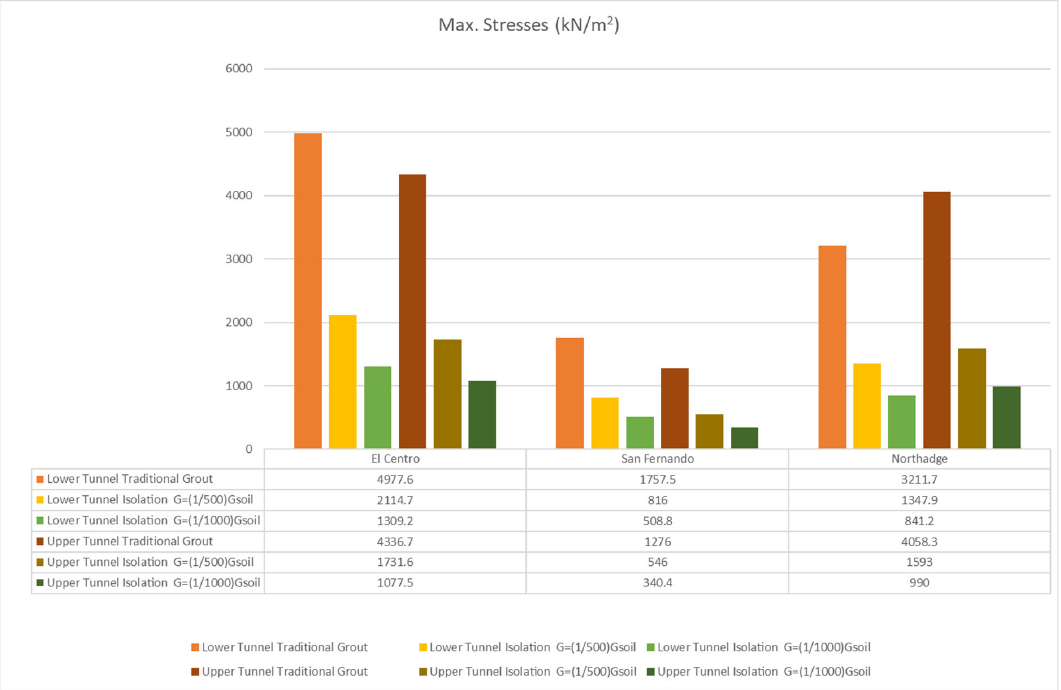
Figure 14. Maximum transverse stresses of the upper tunnel in soft soil and the lower tunnel in stiff soil. Table 6. Effect of using isolation instead of traditional grout.